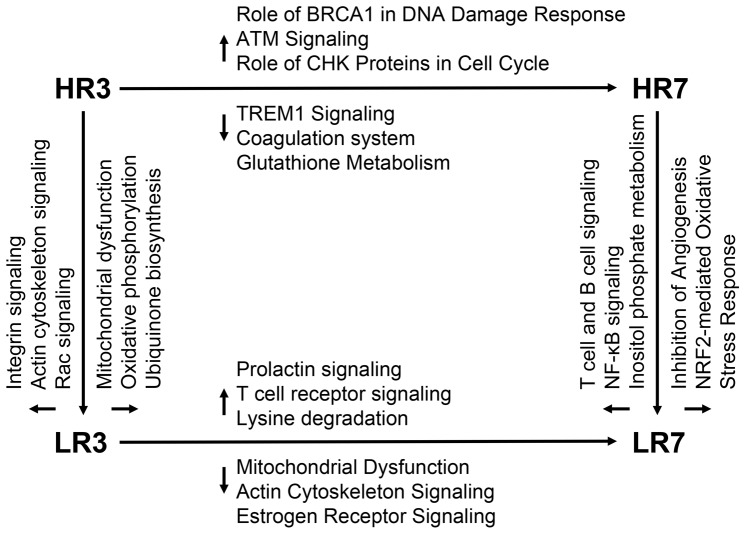
Target genes of TP53 as predicted by IPA.